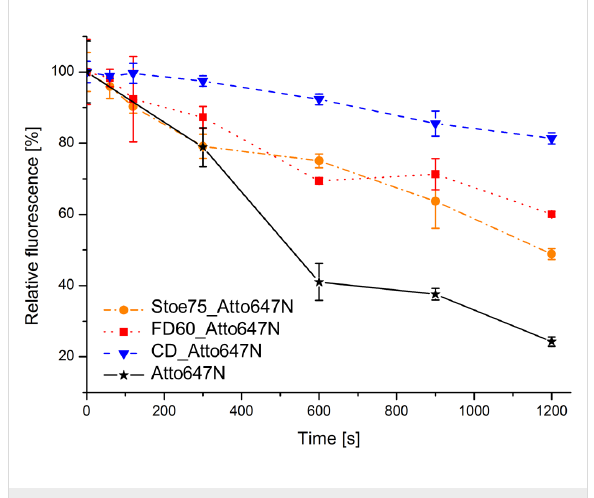
Figure 5: Overview of the photostability measurements of free Atto647N, Stoe75_Atto647N, FD60_Atto647N and CD_Atto647N. The samples were exposed to light from seven LEDs ( λ em = 594–650 nm) and the fluorescence intensity was measured over a period of 20 min.